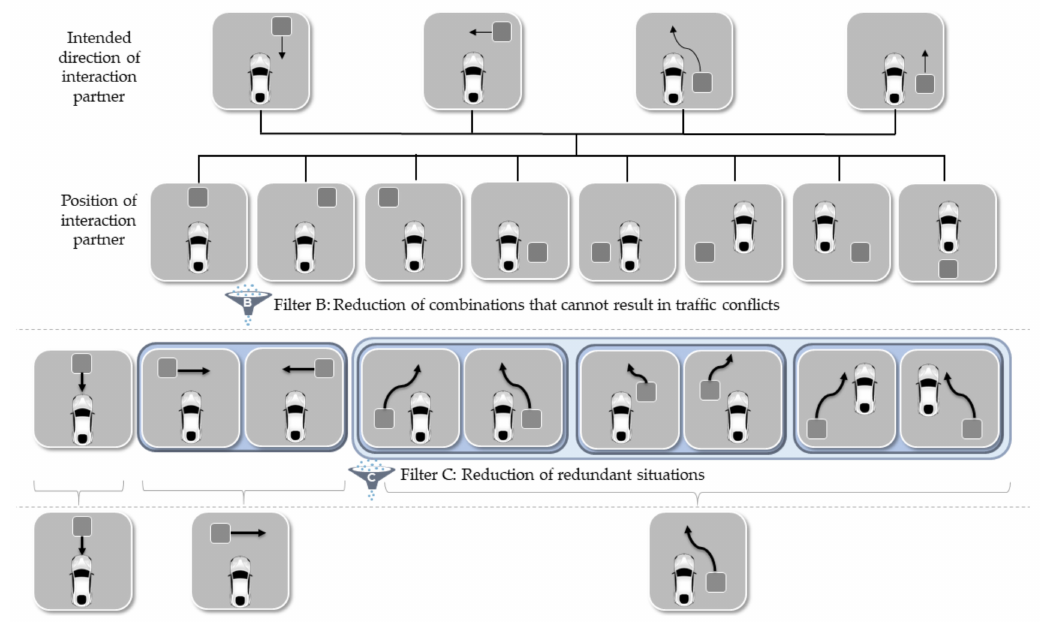
Figure 2. Generic situation-based approach with two filters. Grey squares represent an arbitrary interaction partner, and the white vehicles represent automated vehicles. Blue boxes indicate redundant